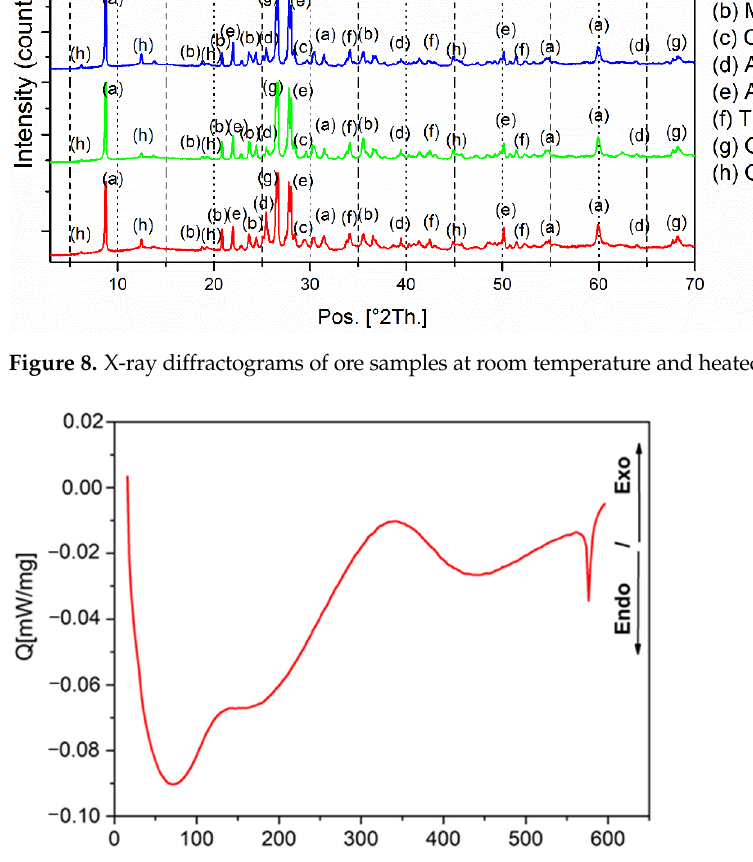
Figure 9. DSC curve for copper ore.